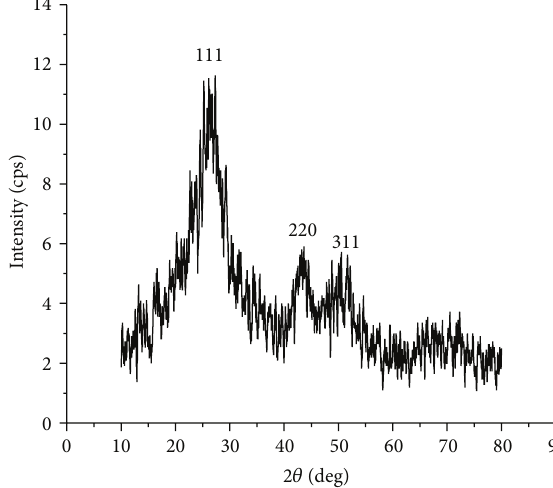
Figure 6: XRD pattern of NAC-capped CdSe QDs reacted for 65